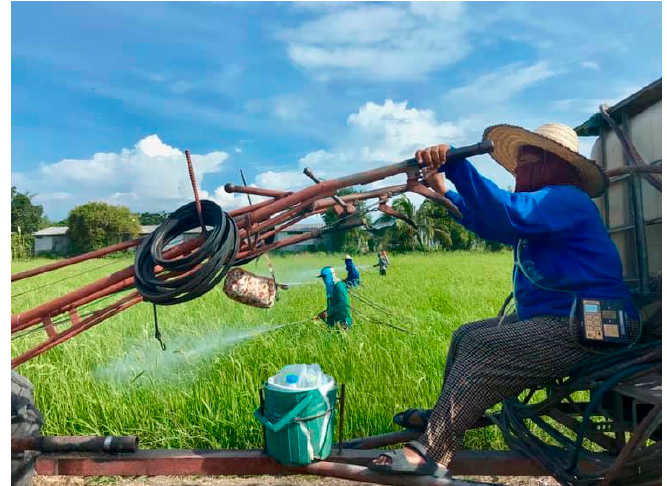
Figure 6. Pesticide spraying.